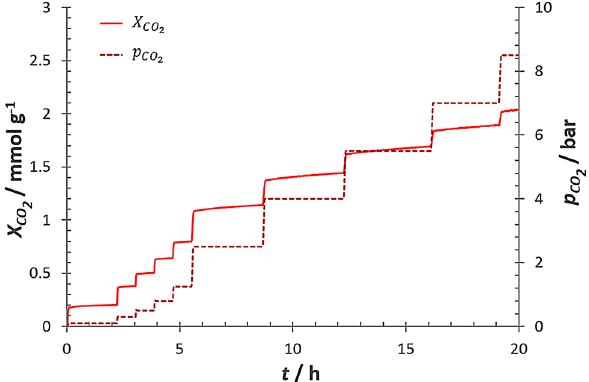
Fig. 11 Time dependent adsorption uptake response induced by a pressure profile of CO Al O core–shell at T = 303.15 K 2 3